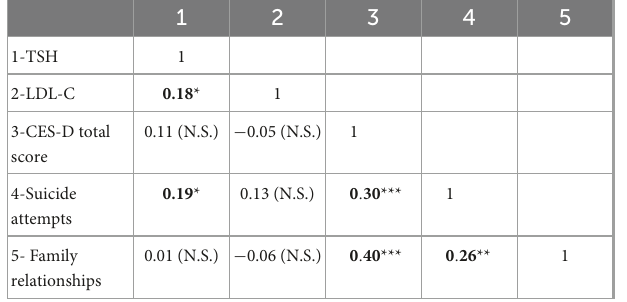
TABLE 2 Partial correlations between suicide attempts, TSH, LDL-C, CES-D total score, and family relationships, controlling for age, gender, recruitment in different settings, and medication.